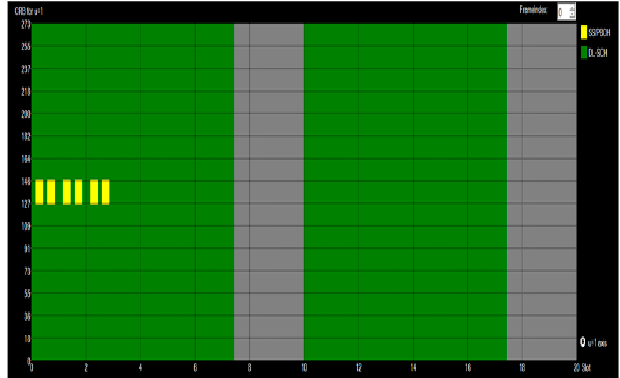
Figure 10. TDD signals #2 frame structure; green and grey blocks represent the resources allocated to data transmission and those allocated to the uplink transmission, respectively.